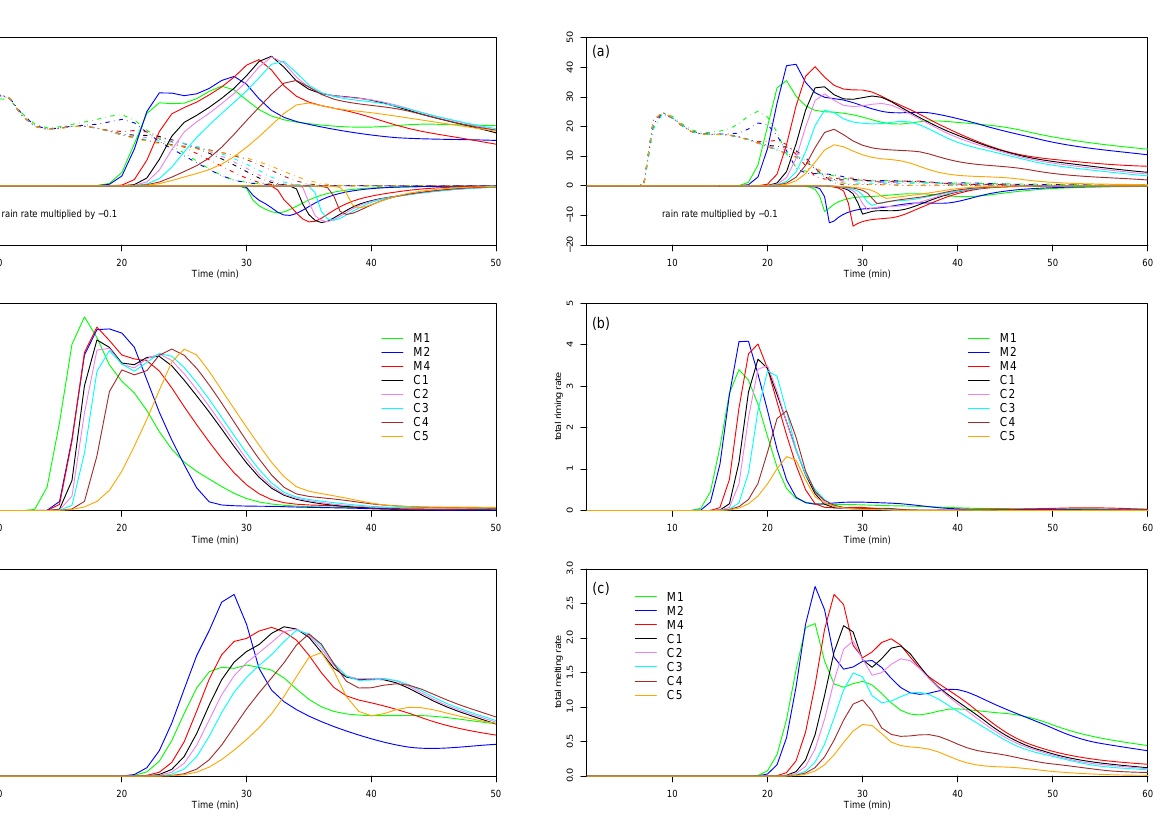
Fig. 10. Texas clouds: (a) The sum of drop mass (gkg − 1 in dash- dotted lines), graupel mass (gkg − 1 in solid lines) at the level just above 0 ◦ C. The precipitation rate in Fig. 4 is also added in the figure for reference. Note that the precipitation rate is multiplied by − 0.1 to avoid congestion in the figure. Temporal variation of total riming rate (b) and total melting rate (c) from TX-v2 cases. The units are gkg − 1 s − 1 .